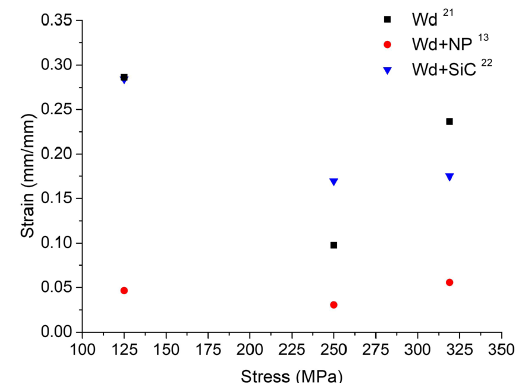
Figure 7. Graph showing strain relationship with stress in the creep test, material ductility calculation at 600 °C.